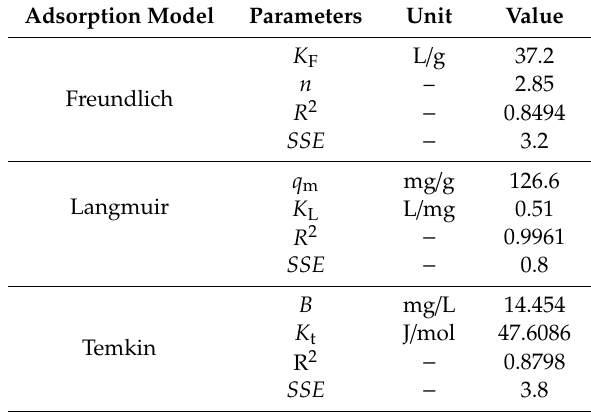
Table 2. Comparison of adsorption isotherm parameters for Cd adsorption onto poultry ash (ash dosage = 5 g/L, adsorption time = 24 h, pH = 5).